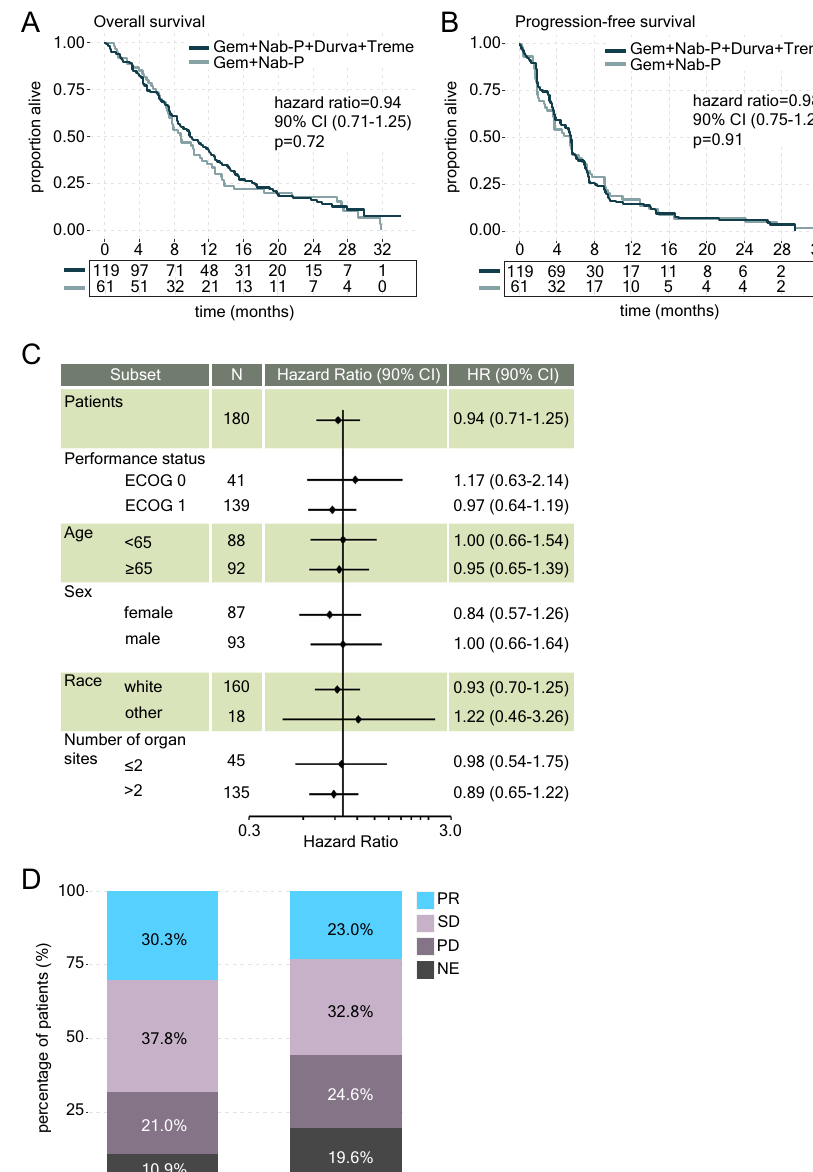
on OS. Measure of center for error bars represents mean values. D Bar plot com- paring differences in objective response rate (ORR) between treatment arms. Hazard ratio and con fi dence intervals (CIs) based on strati fi ed Cox models are shown along with log-rank p values, and statistical tests were two-sided. Source data are provided as a source data fi